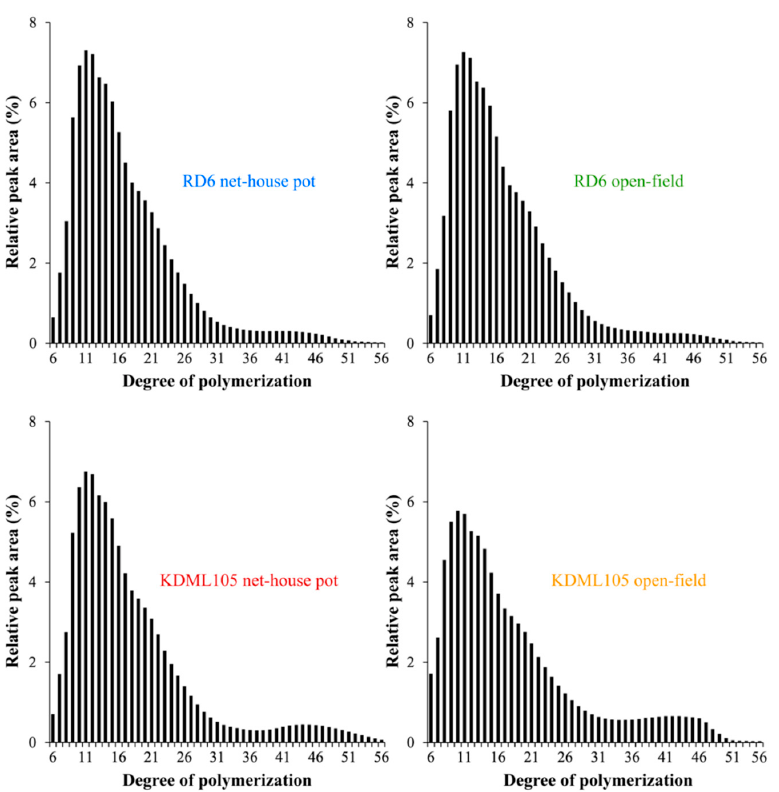
Values are means ± SEM. Means in bold within each column with the * and ** symbols denote statistically significant difference between the two production systems at p ≤ 0.05 and p ≤ 0.01, respectively, by Student’s t -test ( n = 3). Abbreviations: DP = degree of polymerization of the number of glucose units in a branch chain length of amylopectin molecule; CL = average chain length; AGU = anhydroglucose unit.